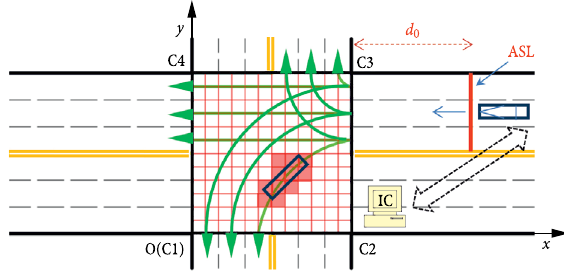
Fig. 1. Intersection mesh of tiles and example of vehicle’s possible routing decisions (IC – Intersection